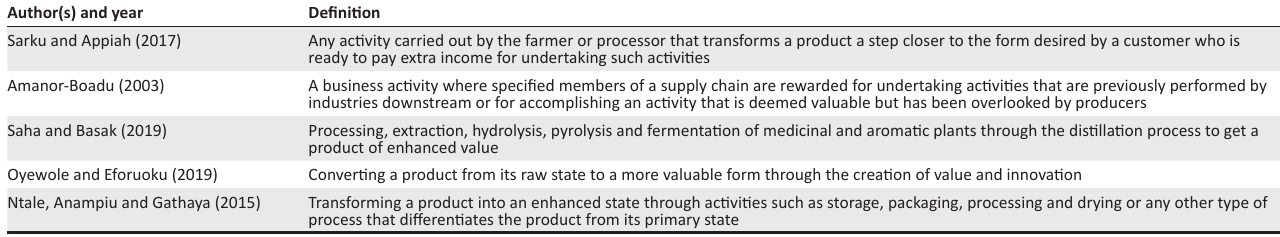
TABLE 1: Featuring definitions for value